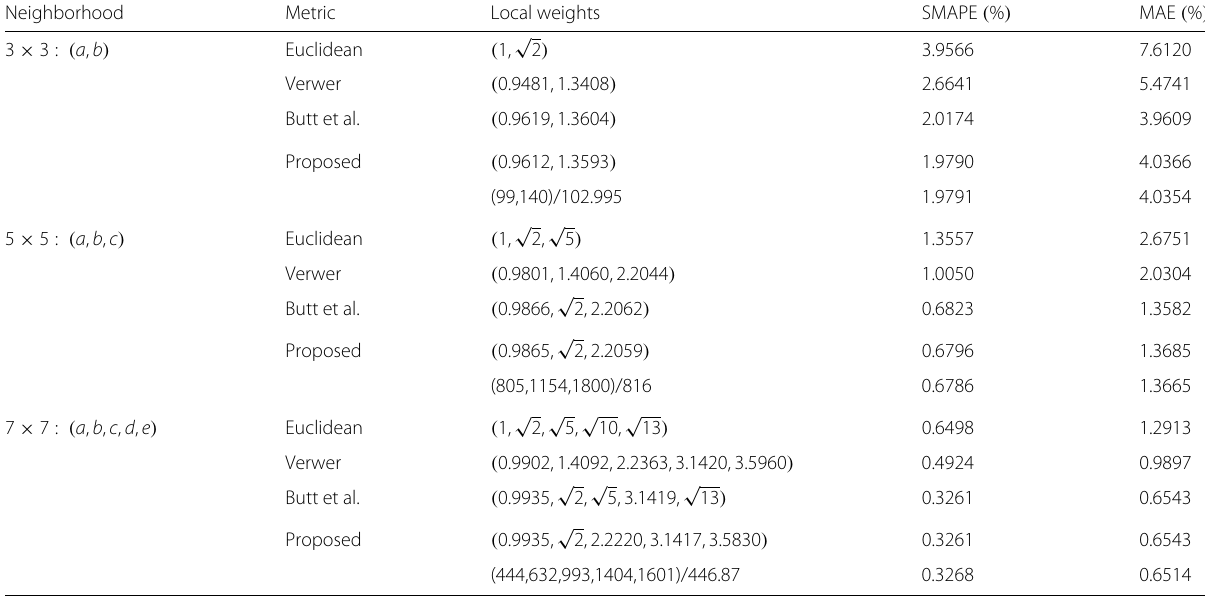
Table 1 Errors generated by chamfer